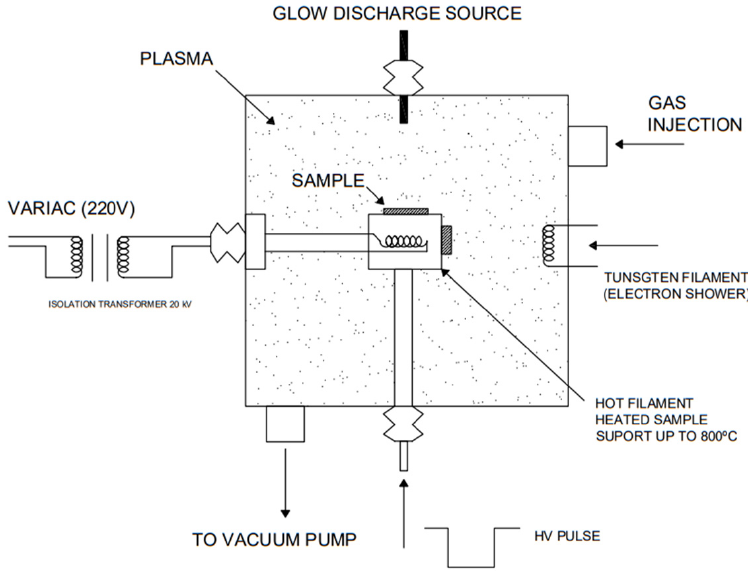
Figure 1. Scheme of plasma immersion chamber.